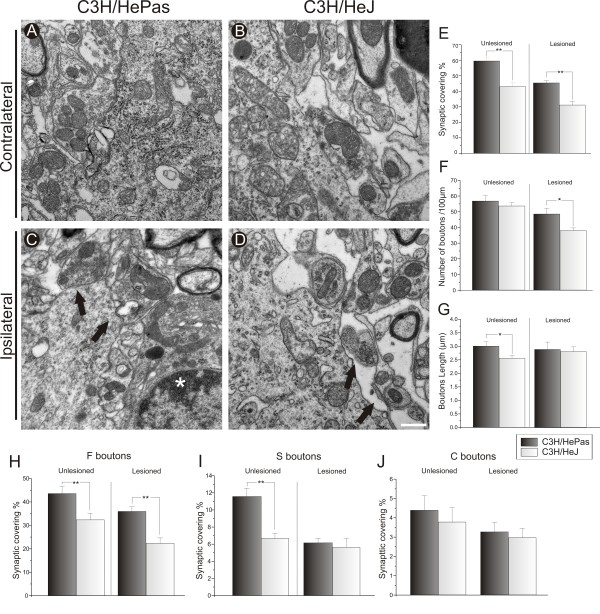
Quantitative ultrastructural analyses of the number of synaptic terminals apposed to the surface of motor neurons after axotomy. Representative micrographs of the surface of (A,B) contralateral and (C,D) ipsilateral motor neurons from C3H/HePas wild-type (WT) and C3H/HeJ TLR4 mutant mice. At 1 week after peripheral lesion, WT mice had greater preservation of synaptic terminals from the surface of (A) unlesioned and (B) lesioned motor neurons. (E) Graph of the total synaptic contact in unlesioned and lesioned neurons; there was greater synaptic covering in WT mice compared with TLR4 mutant mice on both unlesioned and lesioned sides. The black arrows indicate the location of motor-neuron membrane surfaces from which synaptic terminals were (C) in contact with or (D) detached from the surface of the motor neuron. The white asterisk indicates a microglial cell close to a synaptic terminal. E) Graph of the total synaptic covering in unlesioned and lesioned neurons; there was greater synaptic covering in WT mice compared with TLR4 mutant mice on both sides. (F) Graph of the total number of synaptic terminals per 100 μm of motor-neuron membrane; note the difference between genotypes on the lesioned side. (G) Graph of the total bouton length on the motor-neuron membrane in lesioned and unlesioned neurons; the difference is presented before axotomy. (H–J) Graphs of F-, S- and C-terminal numbers per 100 μm of motor-neuron membrane, respectively. A greater preservation of F-type terminals was seen before and after axotomy in WT mice, and, a greater preservation of S-type terminals was seen before lesioning in WT mice. * P<0.05 and ** P<0.01. Scale bar: 0.5 μm.